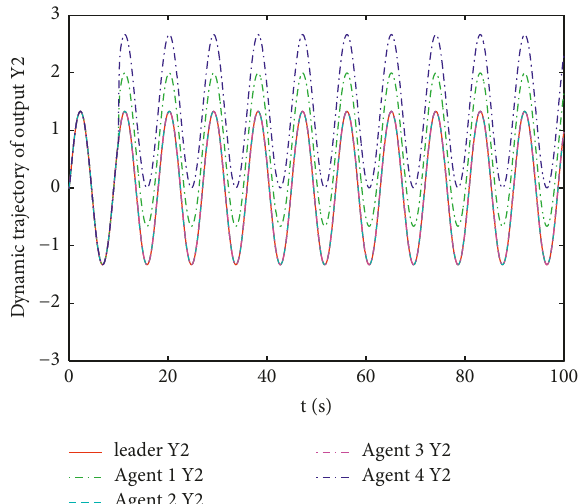
Figure 5: Profiles of output trajectories y